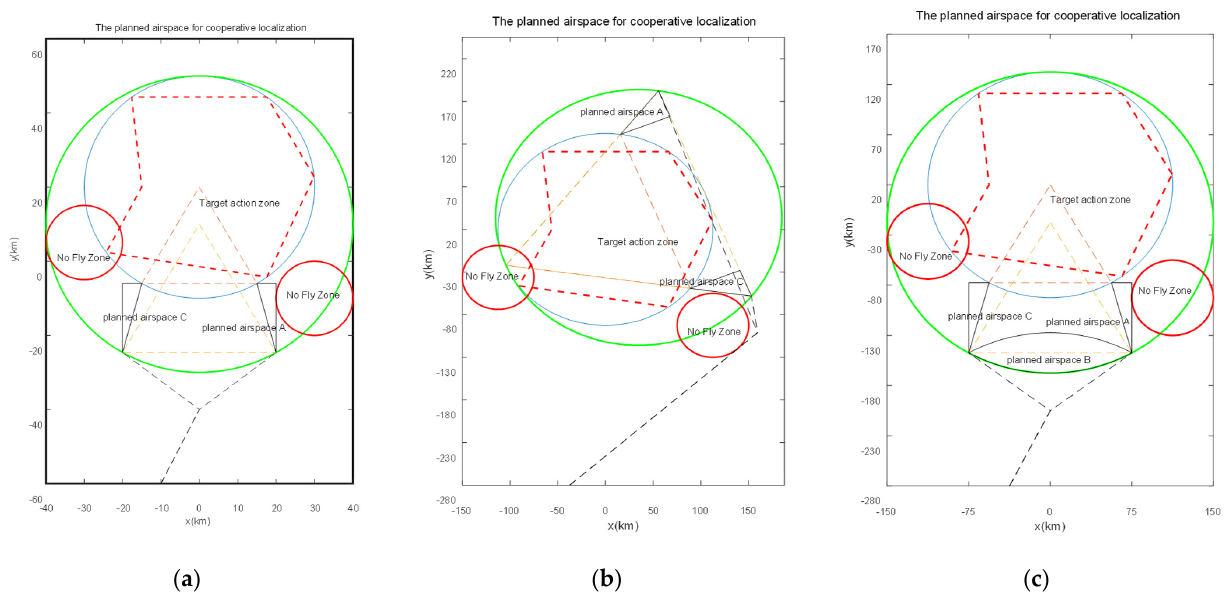
Figure 10. Optimal platform layout: ( a ) direction localization, ( b ) direction and time difference localization, ( c ) time difference localization.